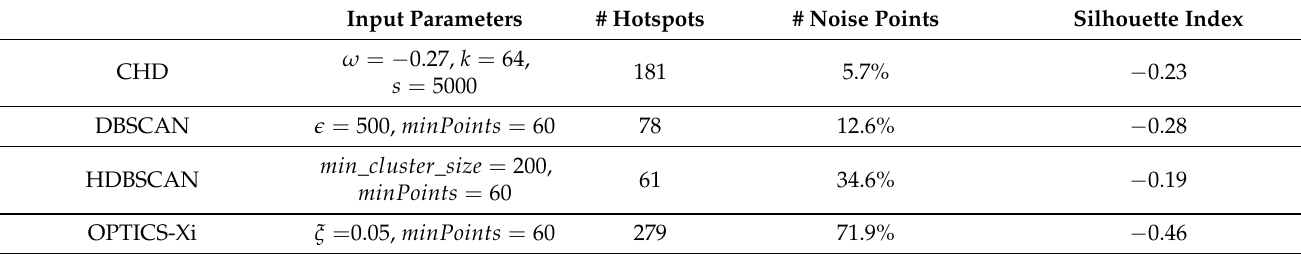
Table 2. Overview of the results obtained by CHD, DBSCAN, HDBSCAN, and